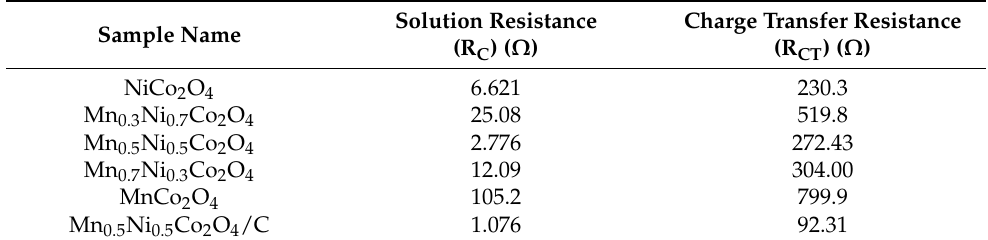
Table 3. Resistance values for the cathodes calculated from the fitting results of Nyquist